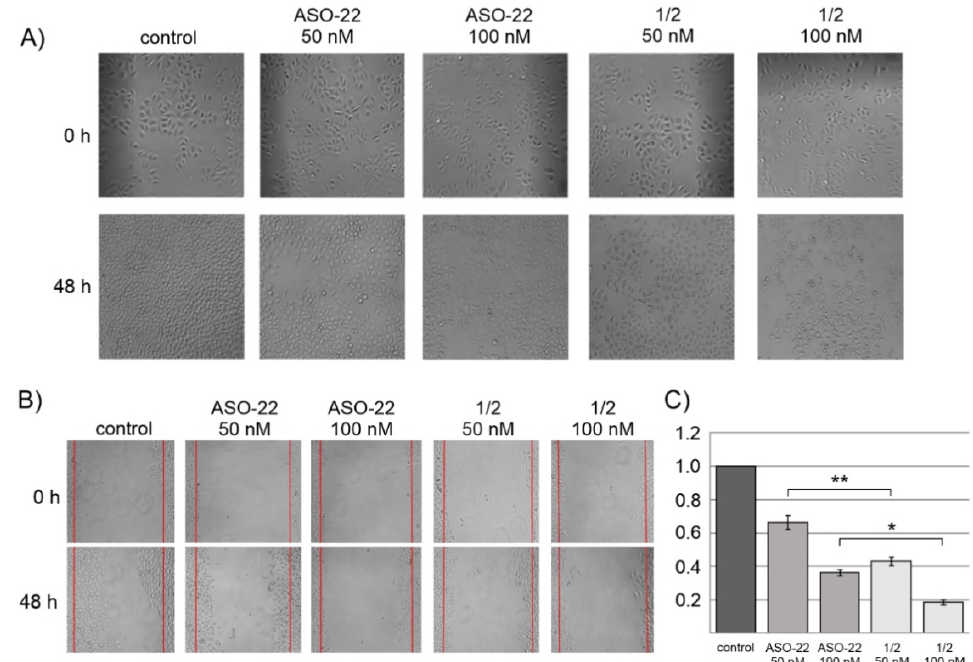
Figure 5. Influence of ASO-22 and nanostructures 1/2 on the HeLa cell phenotype ( A ) and migration rate (wound healing assay, ( B )) and graphical plot of the wound healing assay ( C ). HeLa cells were transfected with ASO-C (100 nM) (nonsense control) or the test compounds (0, 50, 100 nM) in the presence of Lipofectamine 2000. After 48 h of incubation, phenotypic/migration changes of live HeLa cells were microscopically analyzed. All the panels were enlarged 40 times. **** p ≤ 0.0001 (ANOVA and post-hoc Tukey HSD test, * p ≤ 0.05, ** p ≤ 0.01)).